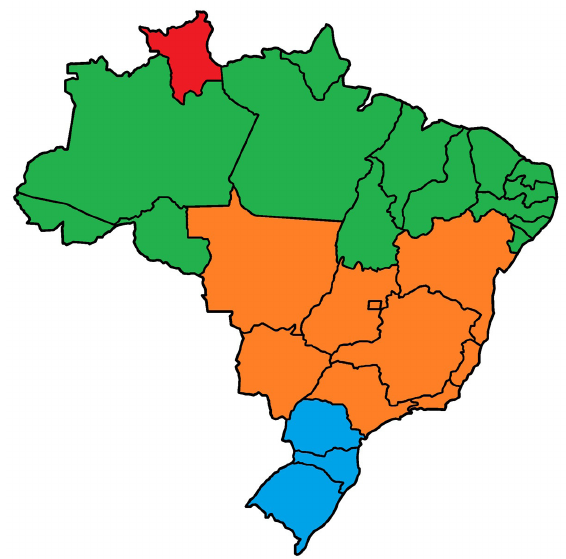
Figure 2. Map of Brazil with states classified within the four “respiratory infection seasonal zones” (RISZ) as defined in this study: “Equatorial-North” (red), “Equatorial-South” (green), “Tropical Midwest and South-East” (orange) and “Sub-tropical South”